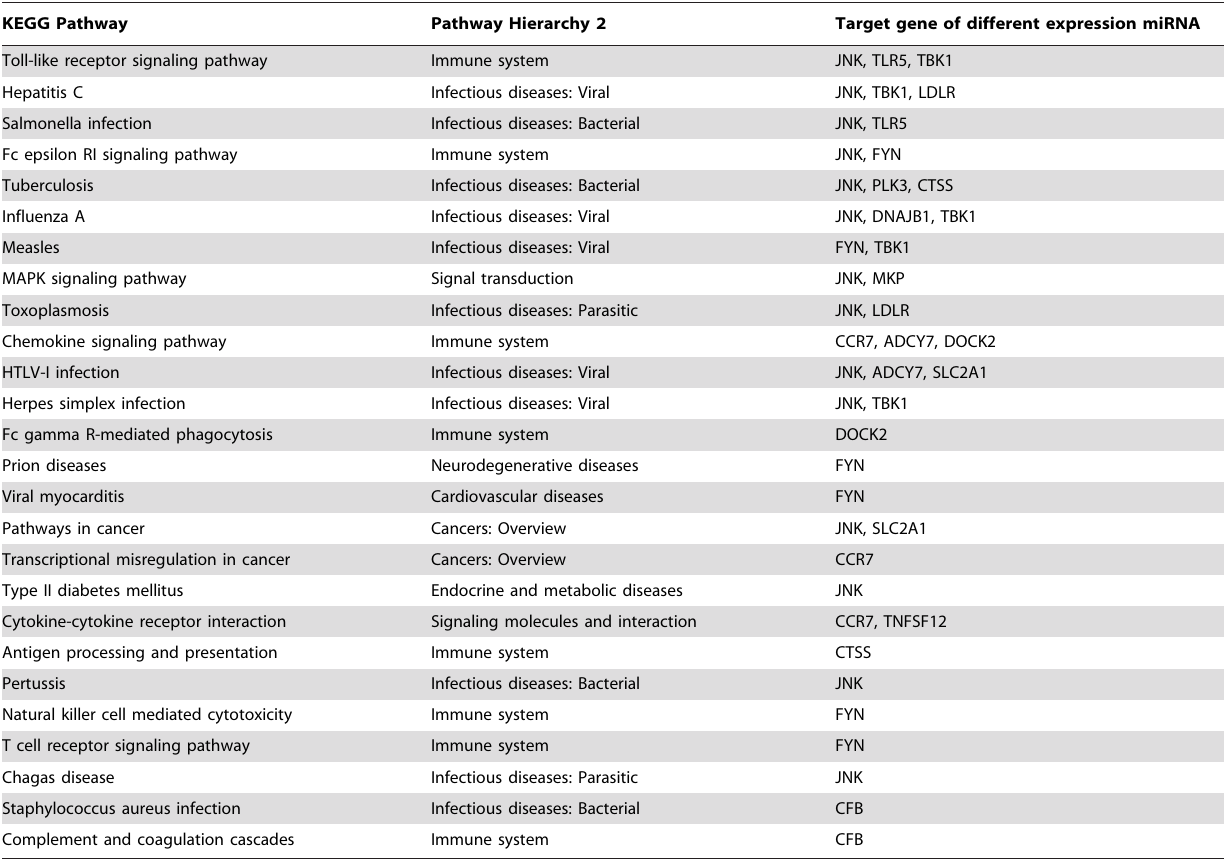
List of gene abbreviations : JNK: c-Jun N-terminal kinase, TLR5: toll-like receptor 5, TBK1: TANK-binding kinase 1, LDLR: low-density lipoprotein receptor, FYN: tyrosine-protein kinase Fyn, CTSS: cathepsin S, PLK3: polo-like kinase 3, DNAJB1: DnaJ homolog subfamily B member 1, MKP: dual specificity MAP kinase phosphatase, DOCK2: dedicator of cytokinesis protein 2, ADCY7: adenylate cyclase 7, SLC2A1: MFS transporter, SP family, solute carrier family 2 (facilitated glucose transporter), member 1, CCR7: C-C chemokine receptor type 7, TNFSF12: tumor necrosis factor ligand superfamily member 12, CFB: component factor B.